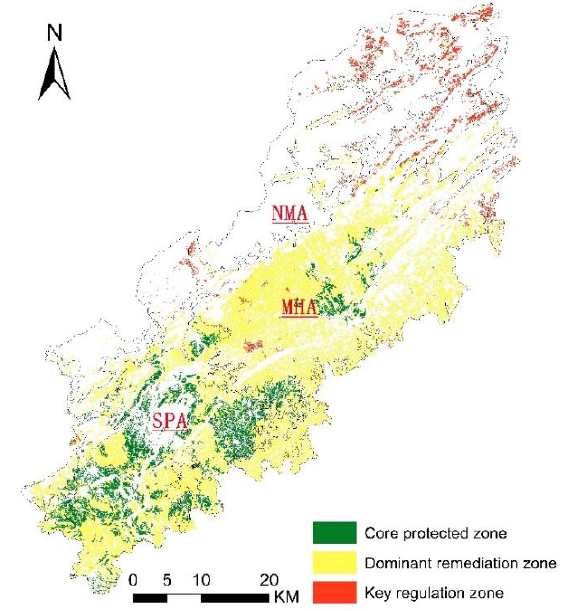
Figure 8. Cultivated land classification based on coupling coordination index.